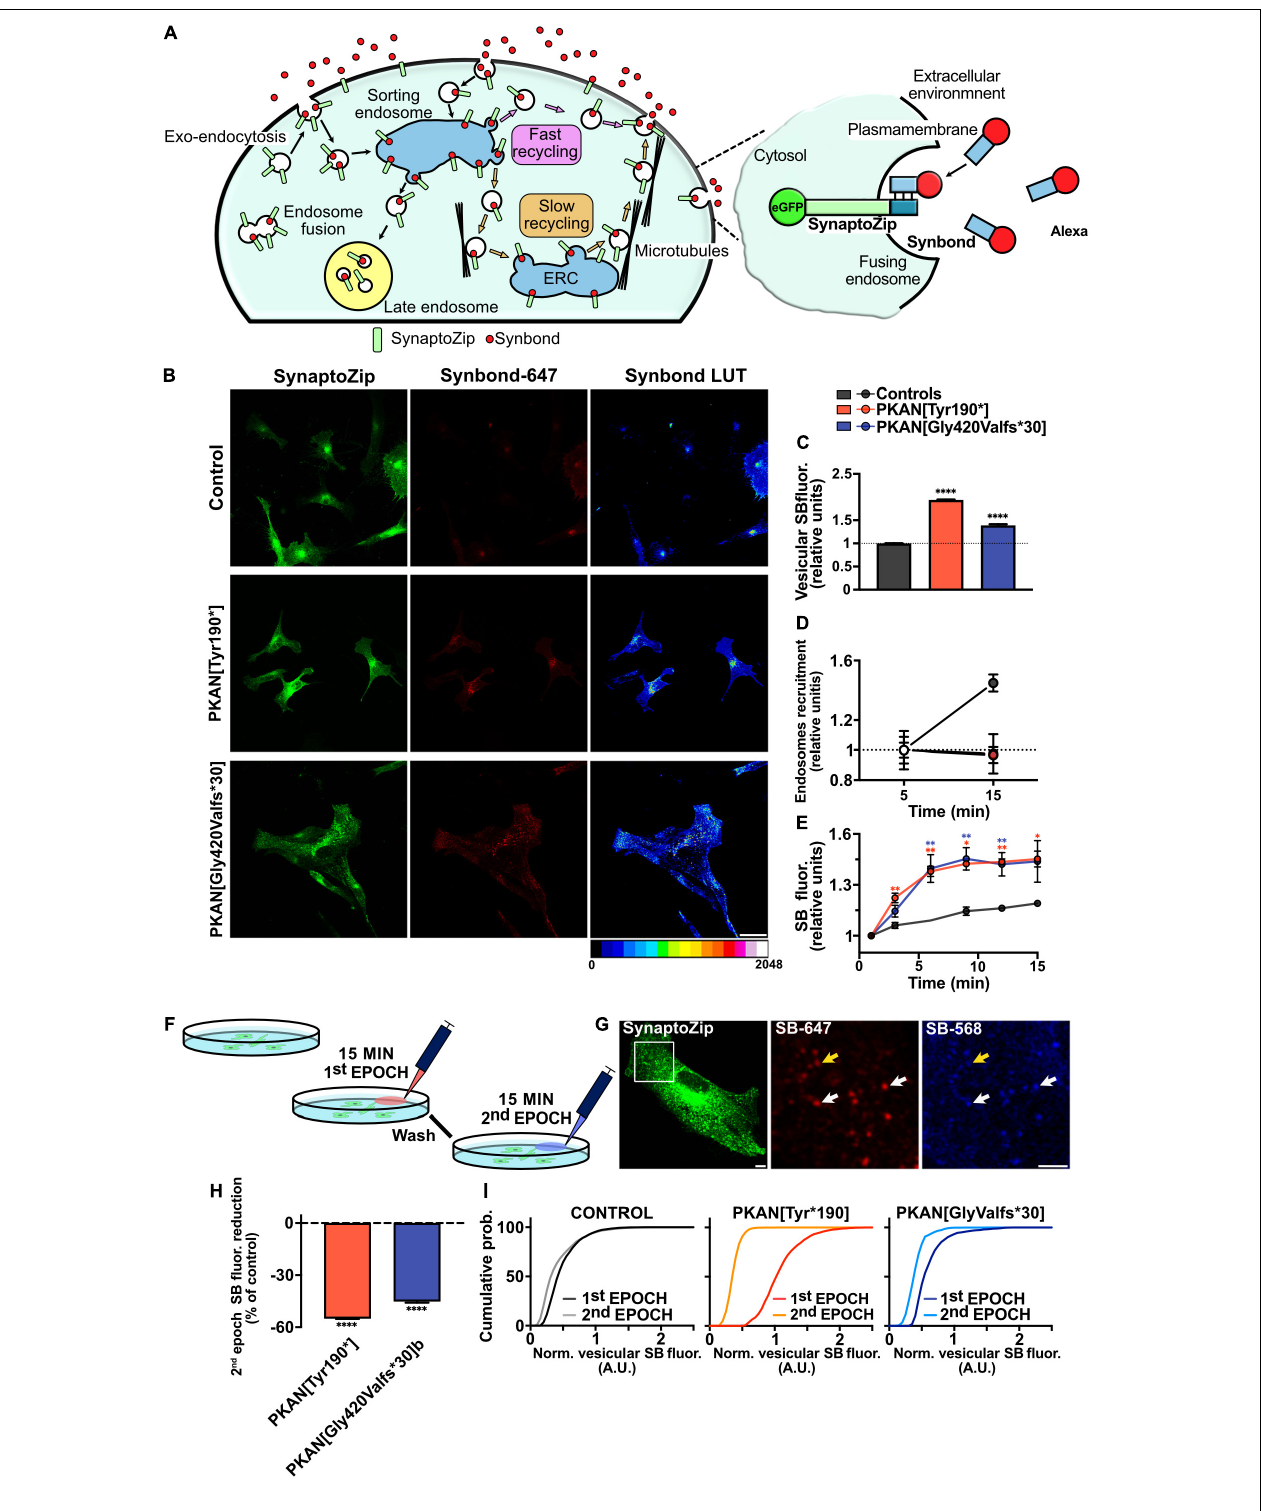
FIGURE 2 | Constitutive Synbond uptake is impaired in PKAN astrocytes compared to controls. (A) Schematic cartoon depicting the structure and functioning of the main endosomal compartments’ fate and their vesicular tagging by Synbond, on the right is a detail depicting the basic functioning of the SynaptoZip-Synbond pair. (B) Confocal of astrocytes from controls and two different PKAN patients expressing SynaptoZip (green) and its Synbond live-uptake (red middle panels, and 16 color LUT right panels, as indicated on the bottom). Astrocytes expressing SynaptoZip were pulsed with 5 nM Synbond for 15 min to image the cumulative activity